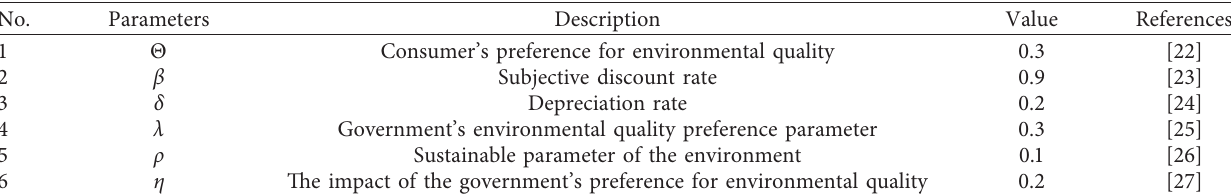
Table 1: Parameters determined by empirical calibration.